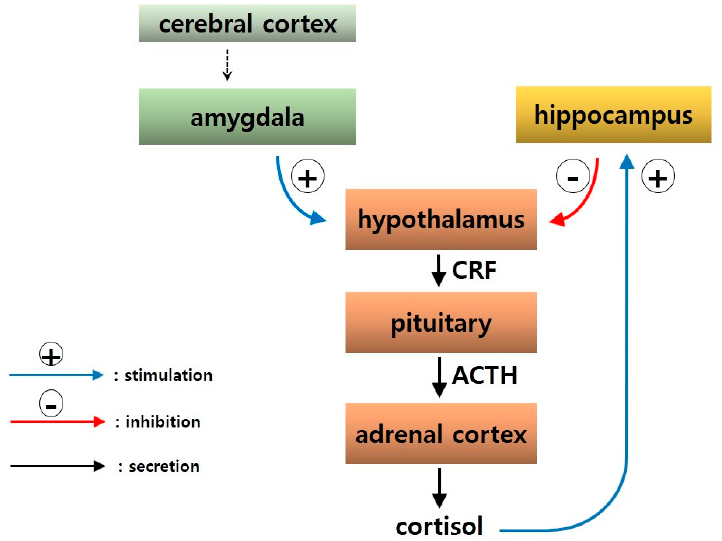
Figure 3. Neural circuitry of the hypothalamic-pituitary-adrenal (HPA) axis as a feedback loop.